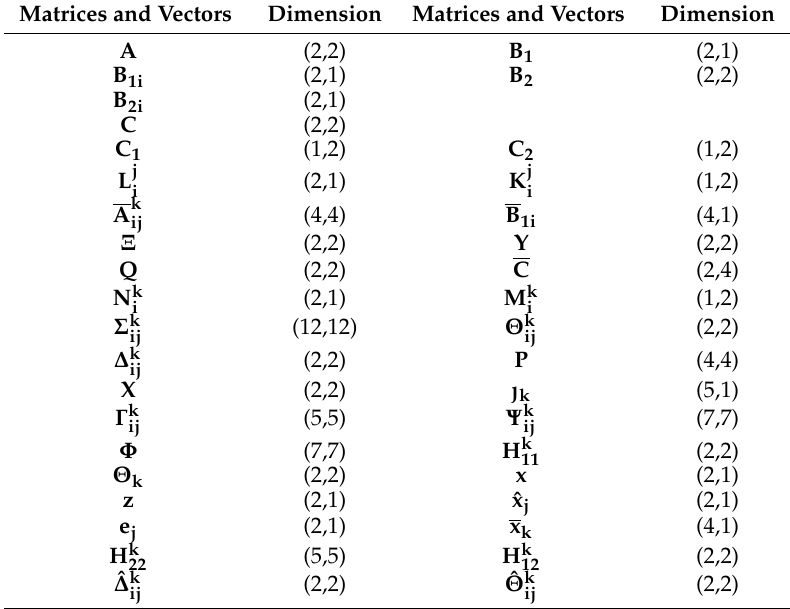
Table A1. Dimensions of matrices and